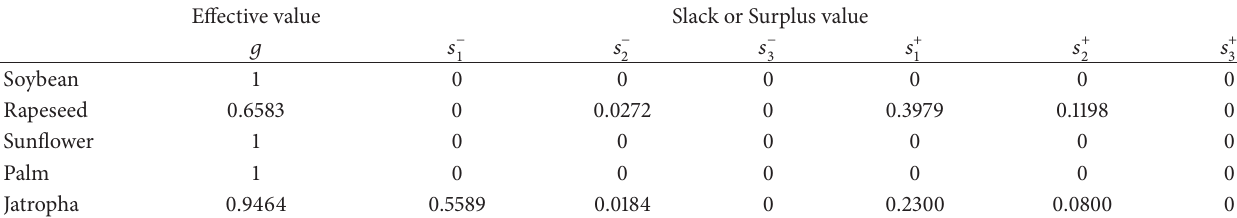
Table 10: The calculating results: effective value, slack value, and surplus value.